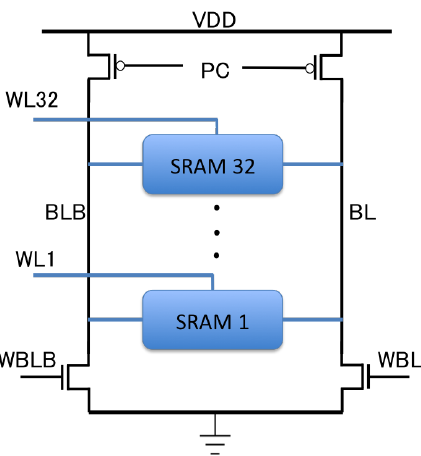
Figure 2. One column of 32 bit SRAM memory. PC is the control signal for precharging, 32 WLs are the word lines for each row of SRAM, and WBLB is the write bit-line bar and WBL is the write bit line, respectively.